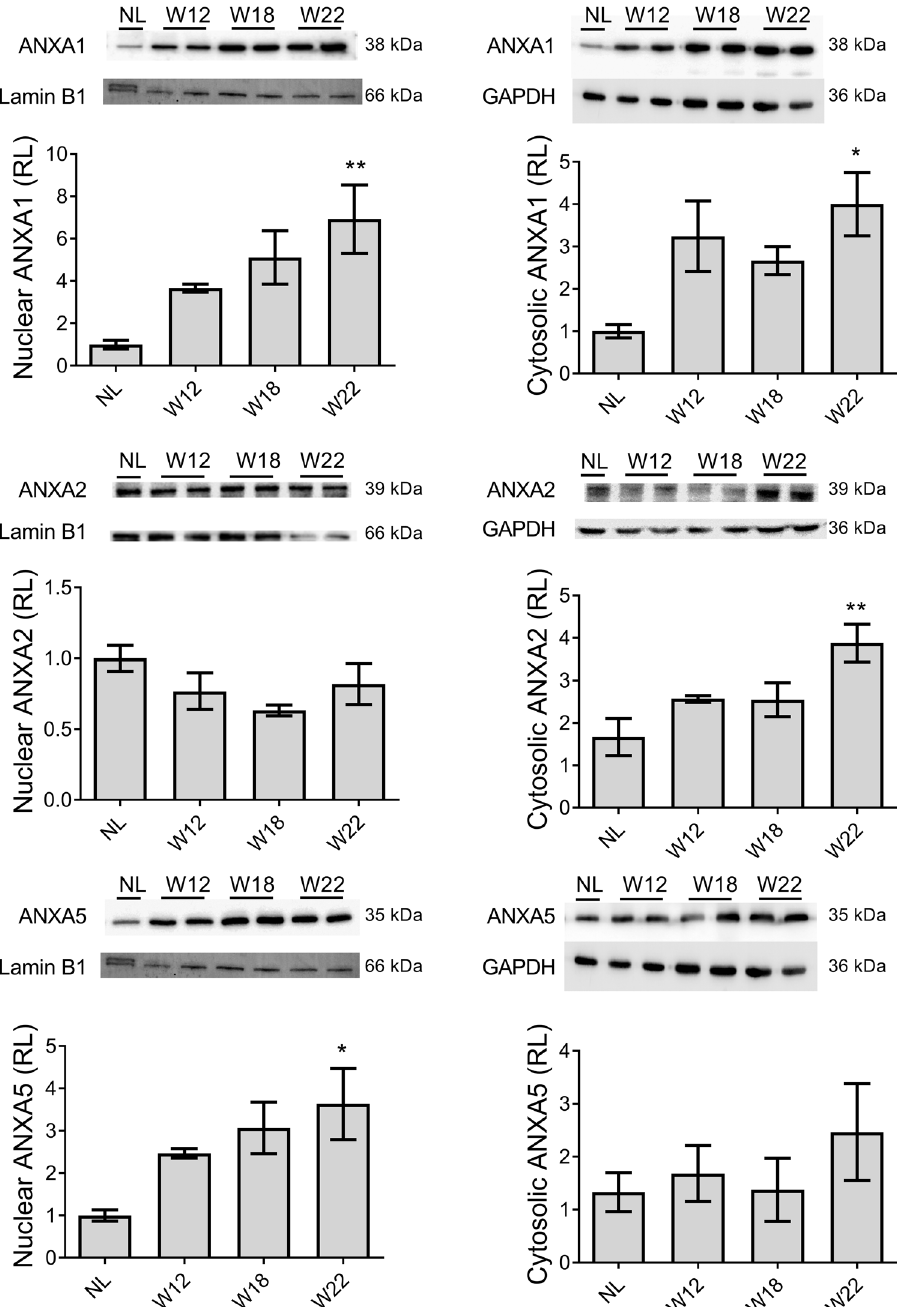
Figure 4. Subcellular expression levels of ANXA1, ANXA2, and ANXA5 proteins. The graphs show nuclear and cytosolic protein expression in liver samples from all experimental groups normalized to Lamin B1 and GAPDH, respectively. Bars show the relative levels (RL) compared to the NL group and represent the mean ± SD. p values were calculated by the ANOVA test. n = 3 animals/group. NL normal liver, W week. ** p < 0.01; * p < 0.05. Images were captured with the Uvitec MINI HD6 photo-documentation system. Original blots of figure are presented in Supplementary Information